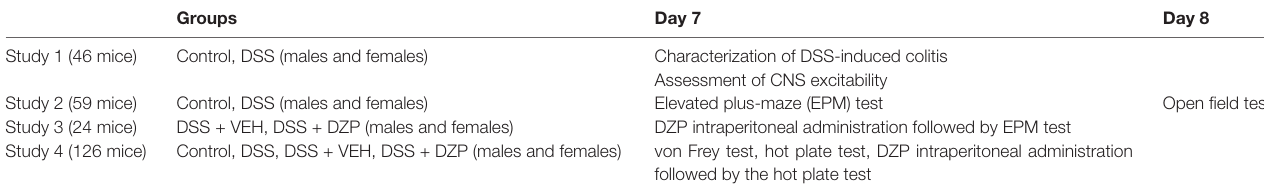
TABLE 1 | Experimental groups and study plan.